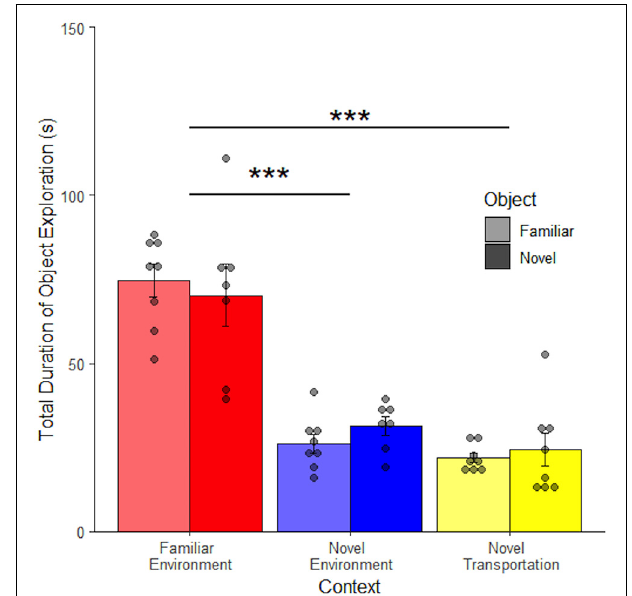
FIGURE 6 | Effects of novel transportation dissipate when an anchored object is introduced. There is no difference in the mean duration of object exploration between the novel and familiar objects or contexts with changes in transportation cues when object play is eliminated via anchoring of the object ( n = 46). Error bars report SEM for each group. Points indicate the total duration of object exploration for each subject grouped into bins of 3.3 s. *** p <